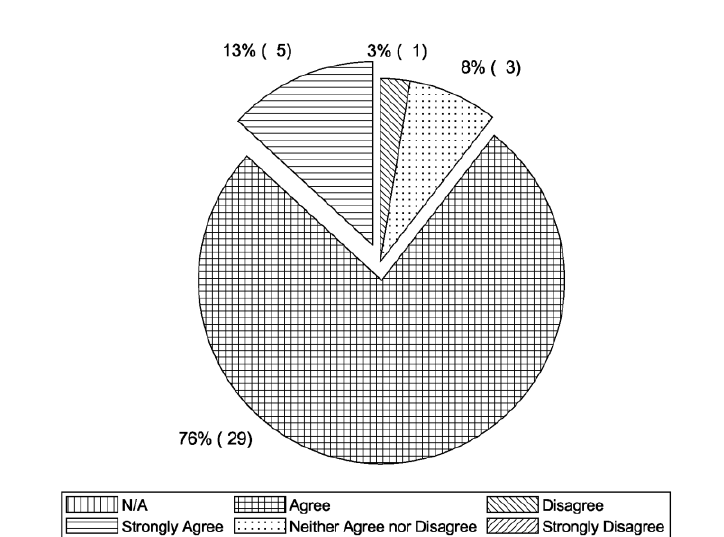
Fig. 10. Projects help students strengthen the decision to study the engineering major that they